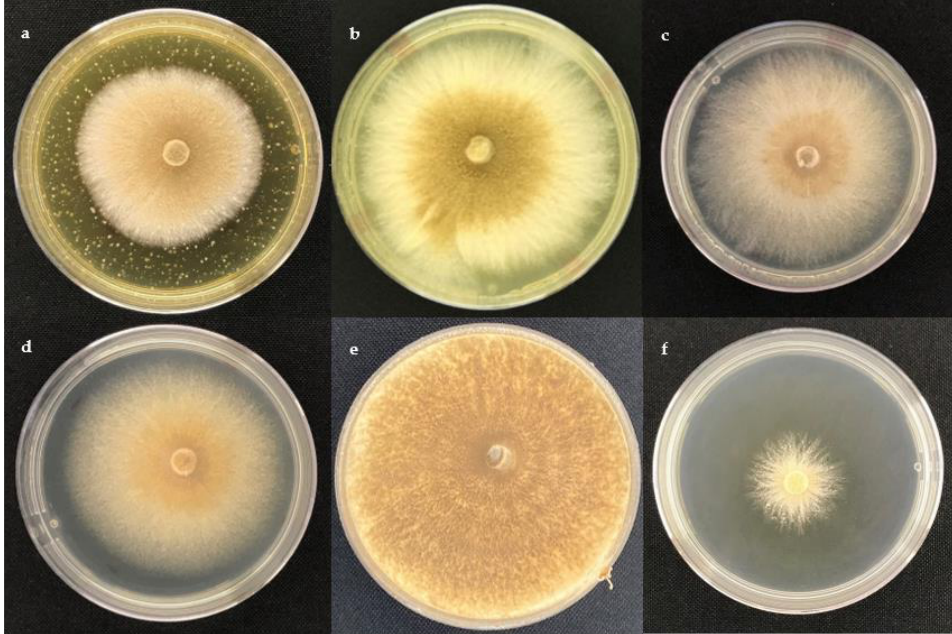
Figure 2. Poisoned culture assay against M. roreri after 14 days of incubation. ( a ) T. spirale (C10) at 1000 μg/mL, ( b ) T. harzianum (C4A) at 1000 μg/mL, ( c ) T. spirale (C10) at 1 μg/mL, ( d ) negative control DMSO, ( e ) negative control PDA, and ( f ) positive control: Azoxystrobin at 10 μg/mL.